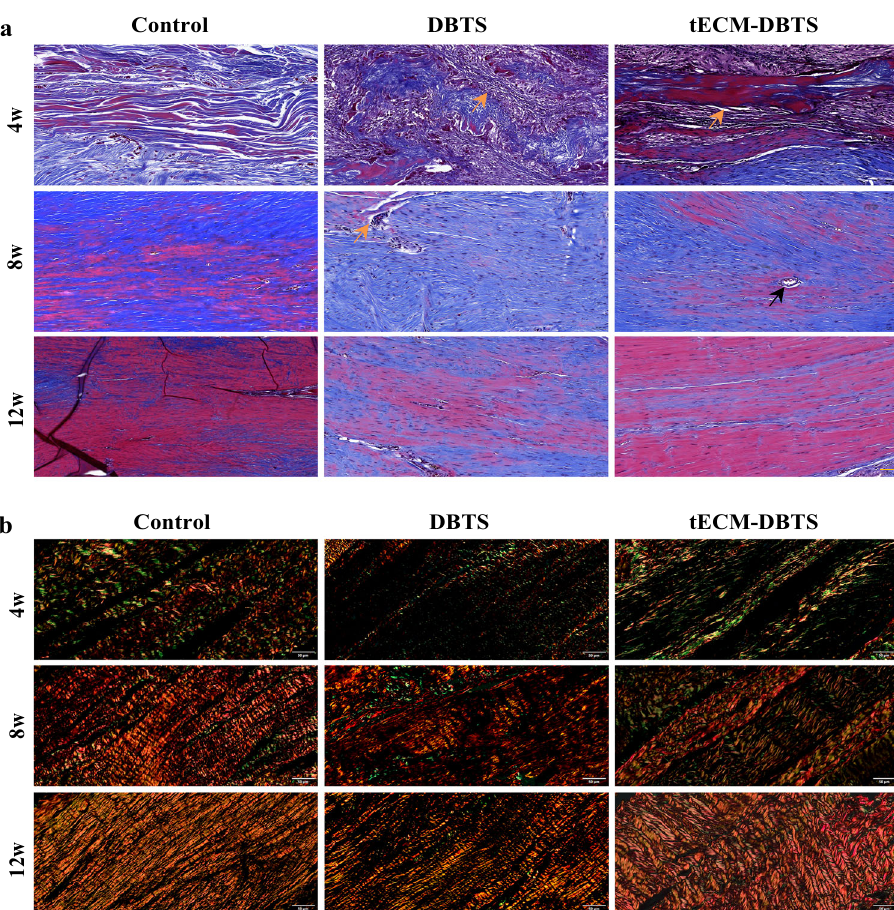
Fig. 7 tECM-DBTS enhances collagen remodeling in a rat Achilles tendons defect model. a Representative Masson ’ s trichrome staining of tendon regeneration in the control, DBTS and tECM-DBTS groups at 4 weeks, 8 weeks and 12 weeks. Orange arrows indicate the scaffolds, black arrows indicate the vascularization. b Representative polarized light images showing the collagen type at the repaired tissue site. Green indicates type III collagen and red indicates type I collagen. Scale bars, ( a ): 50 μ m; ( b ): 50 μ